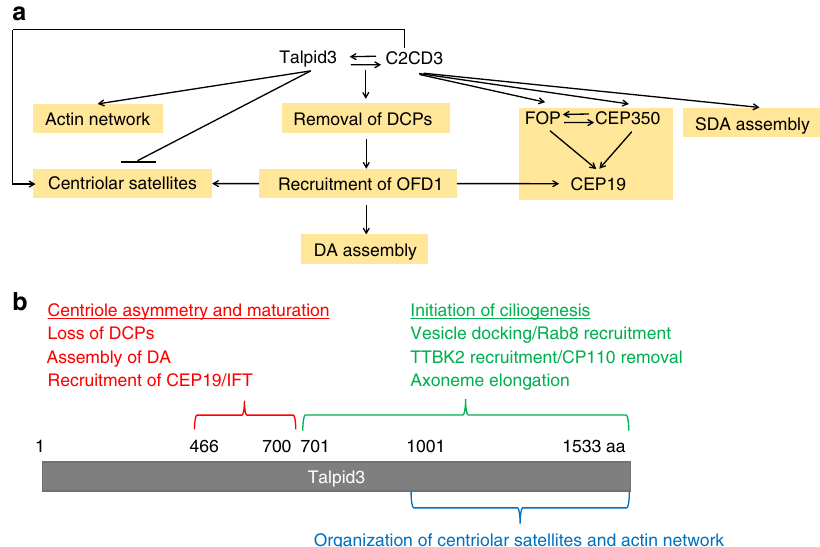
Fig. 9 The Talpid3 – C2CD3 – OFD1 complex as a multi-functional hub that promotes centriole maturation and asymmetry. a Model summarizing how Talpid3, C2CD3, and OFD1 promote centriole maturation and assembly of distal structures. b Schematic of the functional and interacting regions of Talpid3. See text for